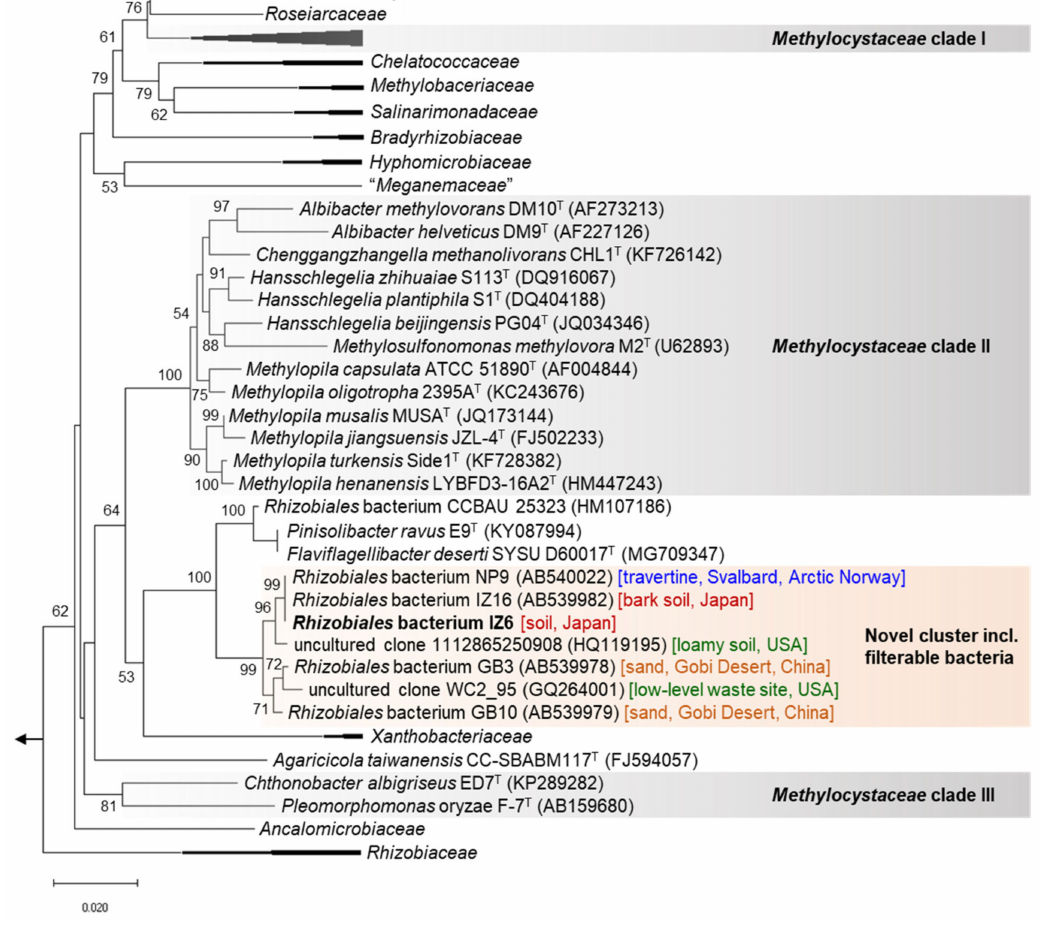
Figure 2. Phylogenetic tree based on near full-length 16S RNA gene sequences of IZ6 and its close relatives in the order Rhizobiales . The evolutionary relationship was inferred using the neighbor-joining method with the Kimura 2-parameter model. There was a total of 1128 positions in the final dataset. Members of the Terasakiella genus ( Methylocystaceae Clade IV) were used as an outgroup. Five genera ( Bartonella , Brucella , Phyllobacterium , Mabikibacter , and Notoacmeibacter ) that are relatively distantly related to IZ6 are not described here. Accession numbers of nucleotide sequences registered in the DDBJ / ENA / NCBI databases are shown in parentheses. For the novel cluster presented in this study, the isolation source and country are shown in square brackets. Bootstrap values > 50% based on 1000 replicates are shown at the nodes. Scale bar, 0.020 nucleotide substitutions per